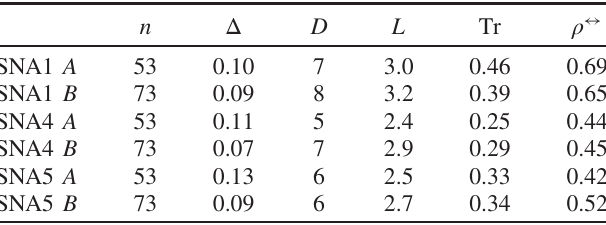
TABLE II. The comparison of network characteristics for first (SNA1), fourth (SNA4), and last (SNA5) collection for fall 2016 (two sections, A and B ): network size ( n ), density ( Δ ), average path length ( L ), diameter ( D ), transitivity (Tr) and reciprocity ( ρ ↔ ). Note that instructional staff is removed from the